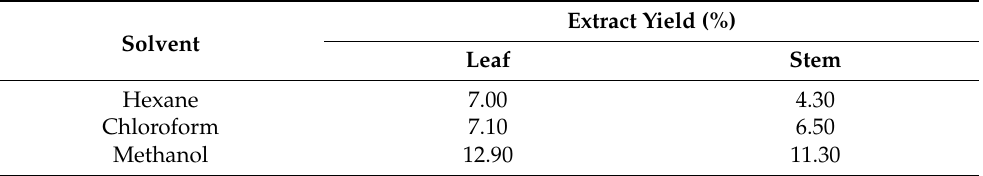
Table 1. Percentage yield of hexane, chloroform and methanol leaf and stem extracts of Combre- tum molle